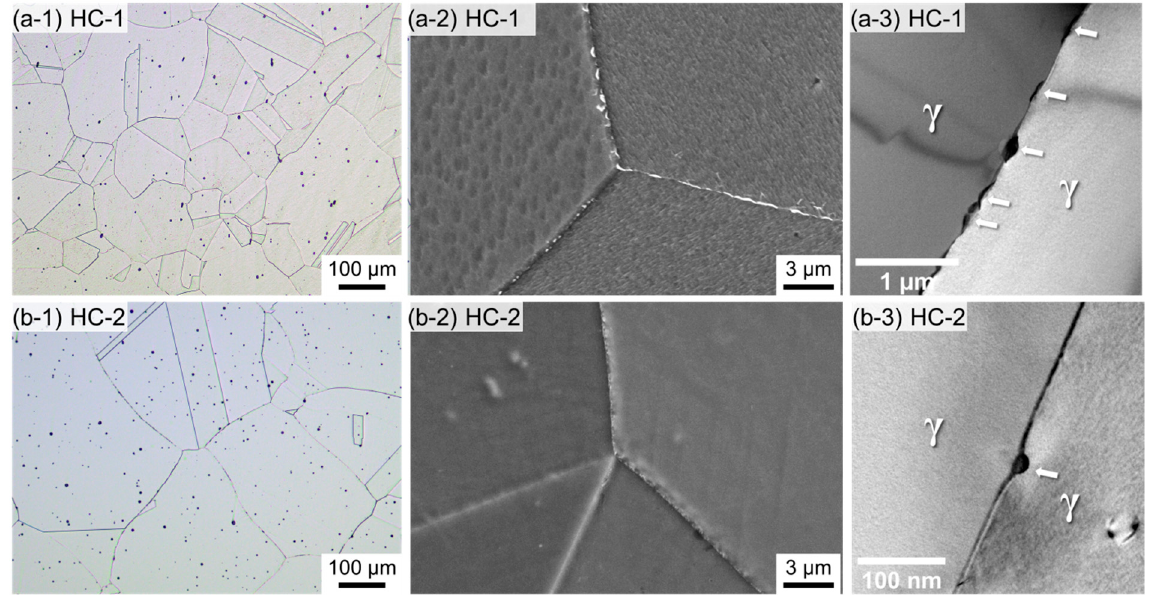
Figure 4. Microstructures of the ( a ) HC-1 and ( b ) HC-2 samples: ( a-1 , b-1 ) light optical microscopy (LOM), ( a-2 , b-2 ) SEM, and ( a-3 , b-3 ) bright field TEM images of the precipitates formed at grain boundaries.